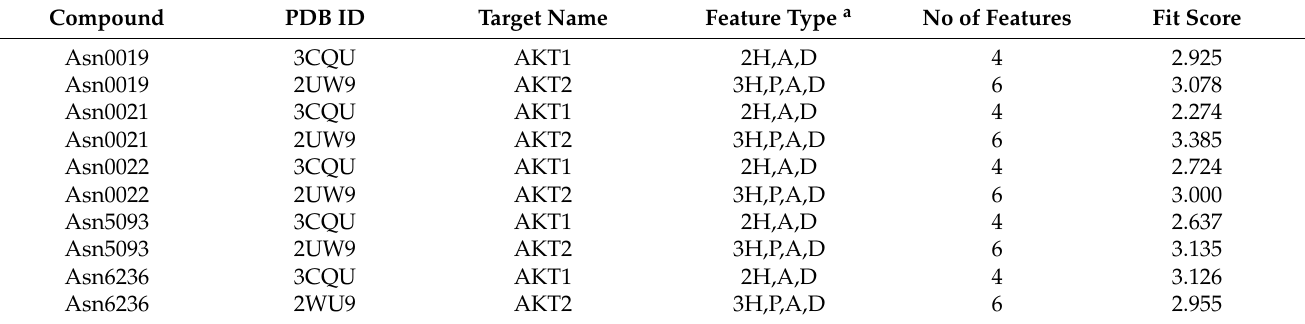
Table 9. Fitting of the virtual hits to the structure-based pharmacophores predicted by the PharmMapper webserver. Compound PDB ID Target Name Feature Type